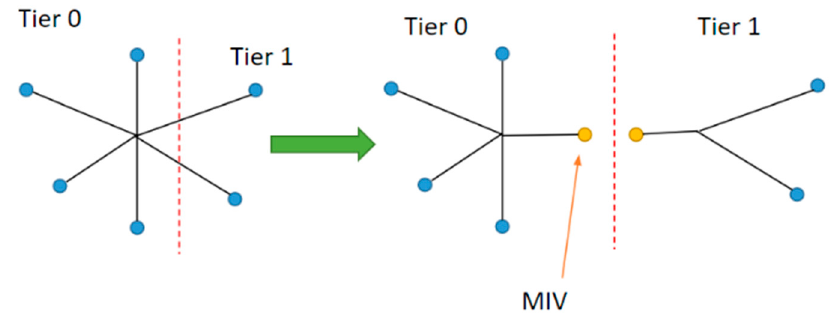
Figure 8. MIV insertion.